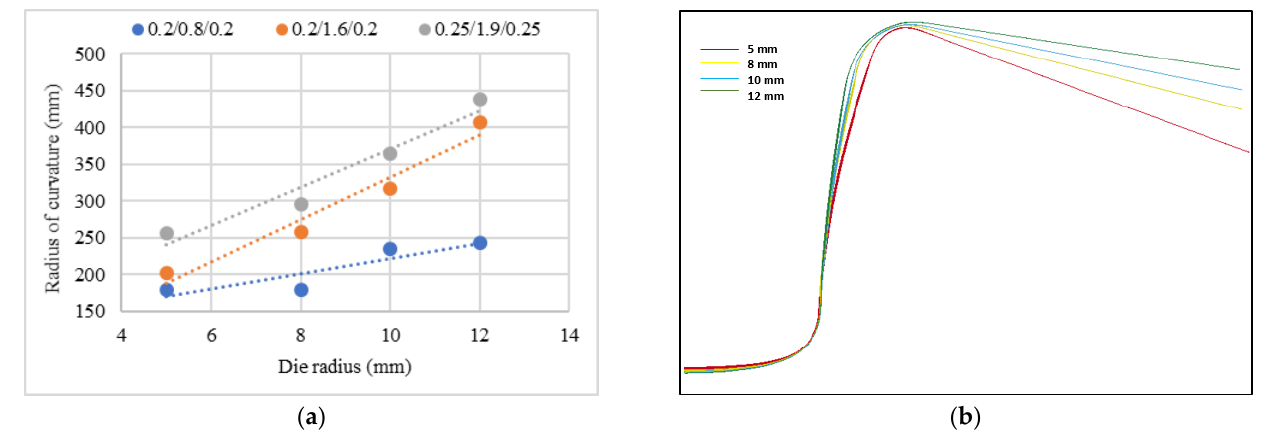
Figure 16. ( a ) Effect of die radius on radius of curvature after springback for three different sand- wich laminate thickness combinations and a punch radius of 8 mm and ( b ) Springback profiles of 0.2/1.6/0.2 mm sandwich laminates with different die radii and a punch radius of 8.